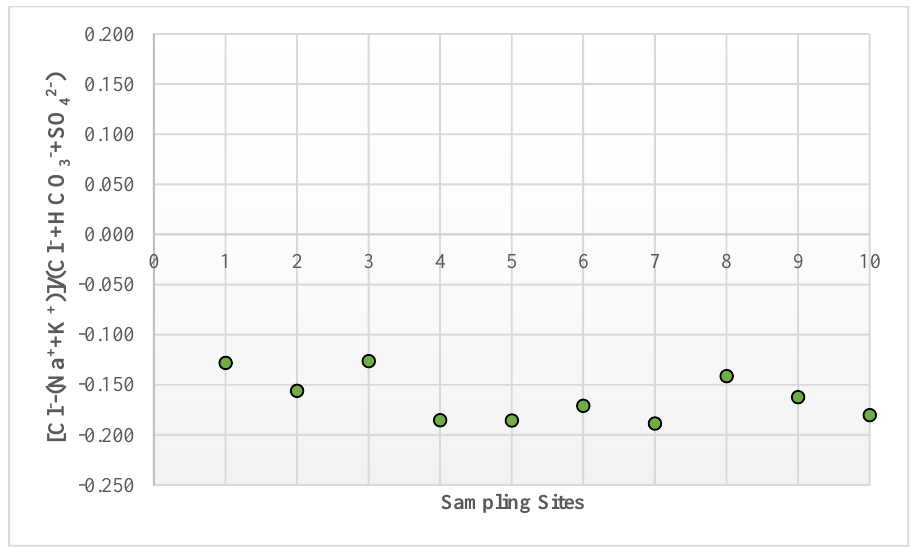
Figure 12. Chloro Alkaline Index type 1 (CAI 1) to determine the type of ion exchange occurred in the studied area.